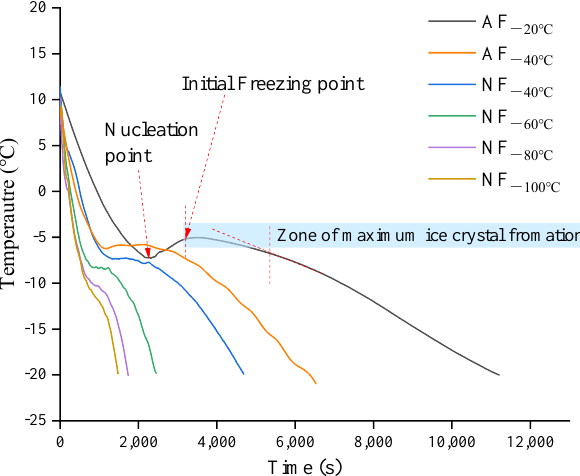
Figure 2. Freezing curve of chestnut kernels treated with different freezing methods.